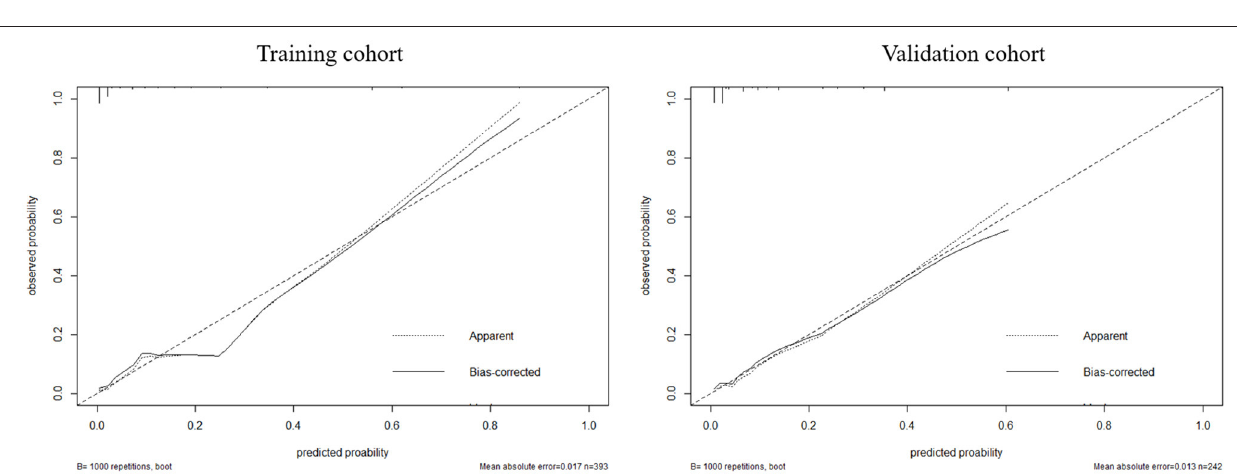
FIGURE 6 | The calibration between the predicted and observed results in the training and validation